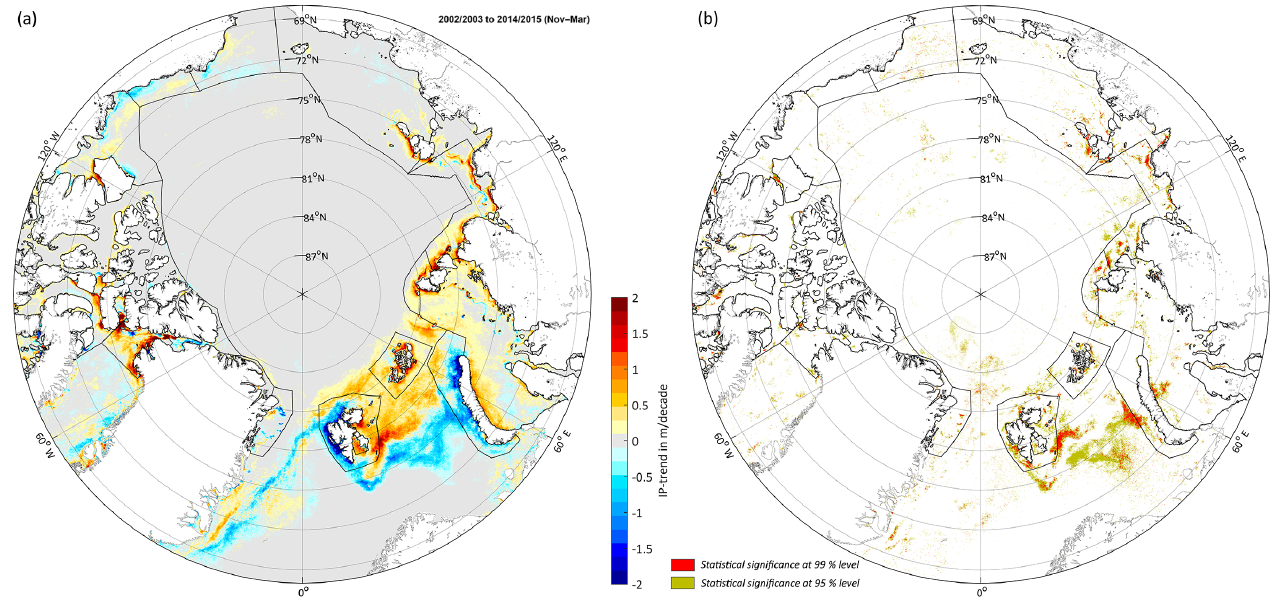
Figure 8. (a) Decadal trends (m per decade) of winter (November to March) ice production in the Arctic, north of 68 ◦ N. Trends are calculated by applying a linear regression to the annual accumulated IP per pixel for the period 2002/2003 to 2014/2015. Areas with statistical significance (based on a two-sided t test) at the 95 and 99% level are depicted in (b) . The margins of applied polynya masks (Fig. 1) are shown as black dashed